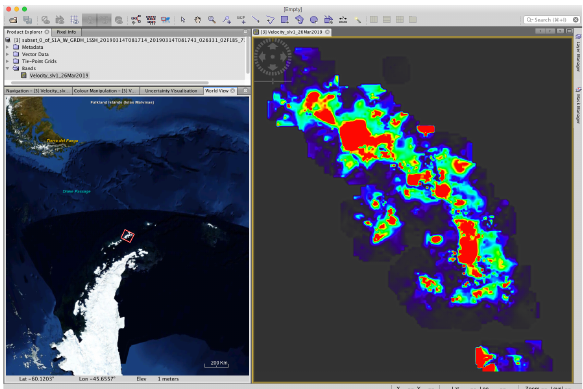
Figure 2: Surface Velocity Flux of Arctoswki Ice field at King George Island. LG “Offset Tracking” process through SNAP software.